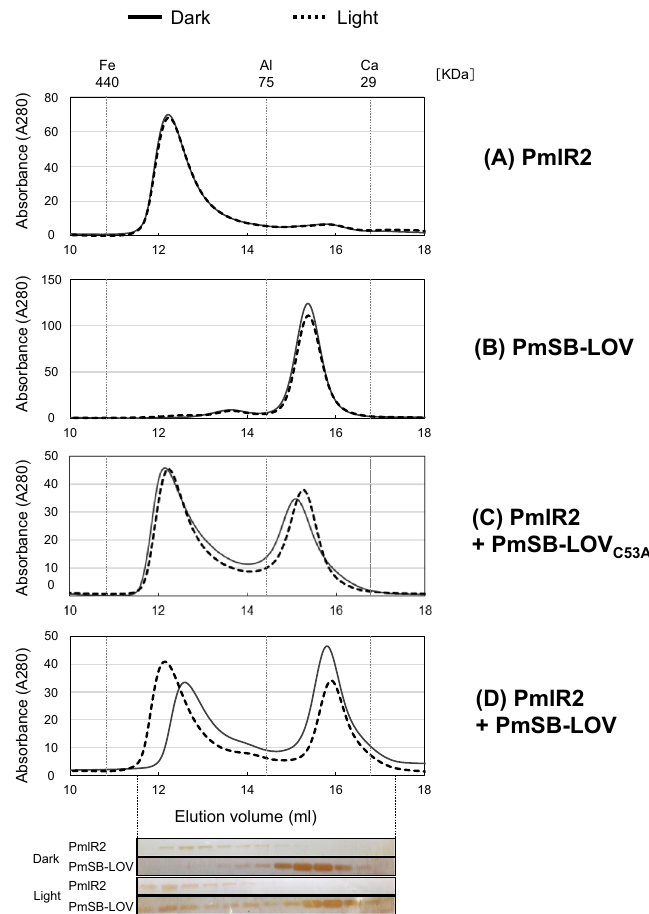
Figure 6. Protein–protein interaction between PmlR2 and PmSB-LOV by gel-filtration chromatography. The recombinant PmlR2 ( A ), PmSB-LOV ( B ), PmSB-LOV C53A and PmlR2 ( C ), and PmSB-LOV and PmlR2 ( D ) incubated under dark (solid line) and light (dashed line) conditions were applied to a Superdex 200 HR 10/30 column on an ÄKTA FPLC system. PmlR2 (200 µL; 0.43 mg/mL), PmSB-LOV (200 µL; 0.47 mg/mL), PmSB- LOV C53A (200 µL; 0.21 mg/mL) recombinant proteins were used. The column was equilibrated and developed with 1 × PBS at a flow rate of 0.25 mL/min. Molecular size standards (Fe: Ferritin, Al: Conalbumin, and Ca: Carbonic anhydrase indicating 440, 75, and 29 kDa, respectively) were applied. White light was applied at approximately 50 µmol s −1 m −2 for 5 min. SDS-PAGE and silver staining for panel D is shown at the bottom. Two independent experiments in technical replicates were performed, and representative data were shown. The original and unprocessed versions of the full-length stained gels were included in Fig.